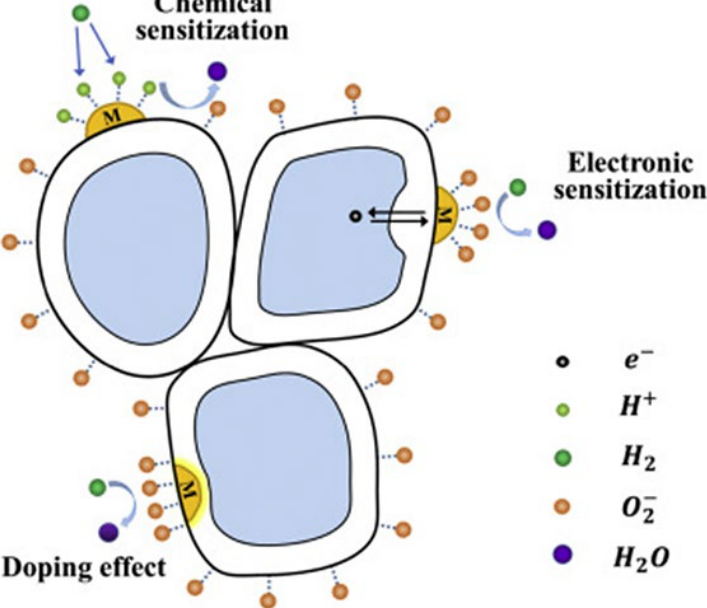
Figure 27. A schematic diagram showing the surface-sensitization effect (chemical sensitization and electron sensitization) and bulk doping of TiO 2 ; here, M is labelled for metal, arrows represent the motion of election. Reprinted from [15].